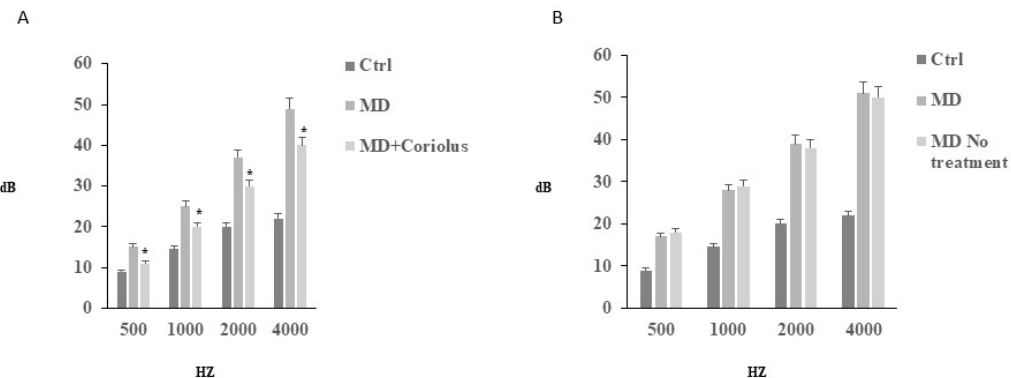
Figure 1. Tonal audiometry analysis. Tonal interest was centered on medium–high frequencies, with an average intensity of 55 dB loss. All subjects reported in both T0 ( B ) and T1 ( A ) phases no significant changes, either in the frequency range, or in the average loss in dB. Speech audiometry analysis, revealed in subjects of group A, who received mushrooms, a significant improvement of intellection threshold, i.e., the ability of verbal discrimination, respect to the initial T0 phase, where the threshold of intellection and perception that is 100% of the given words, was assumed to be 75 db.